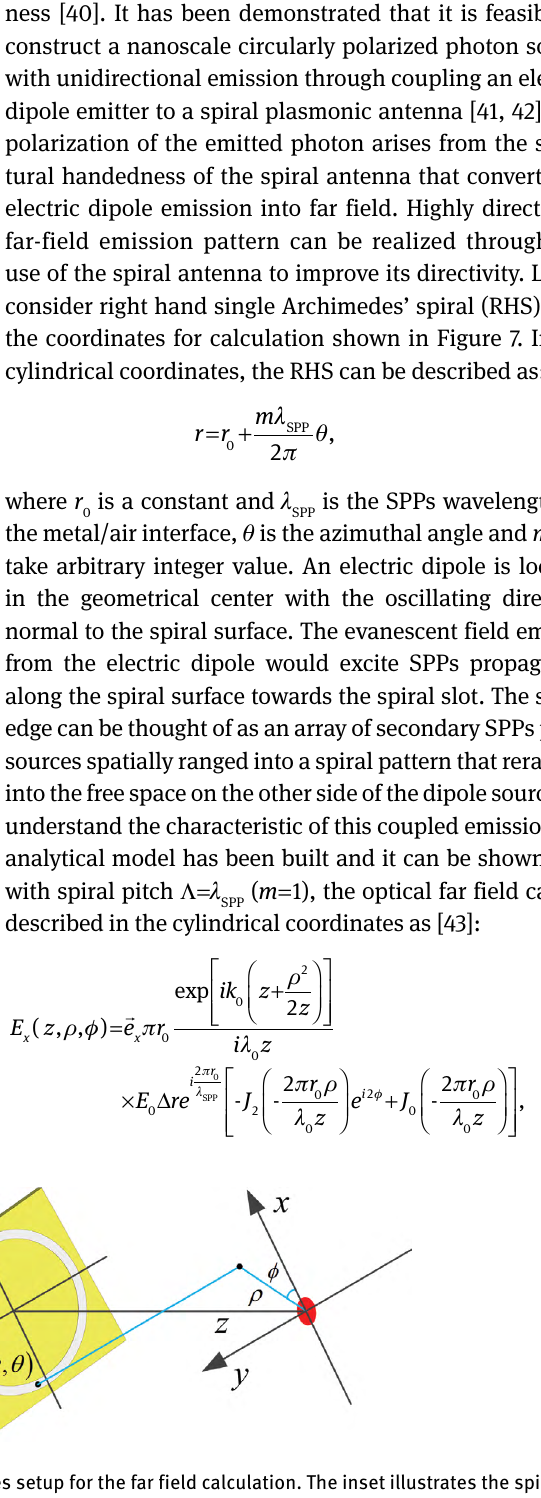
Figure 7 Illustration of a right hand spiral structure and the coordinates setup for the far field calculation. The inset illustrates the spiral structure viewed from the left and the coordinates used in the analytical calculation. Adapted from Ref.